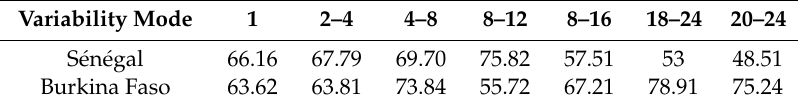
Table 5. Percentage of consistency between precipitation and the TSA index